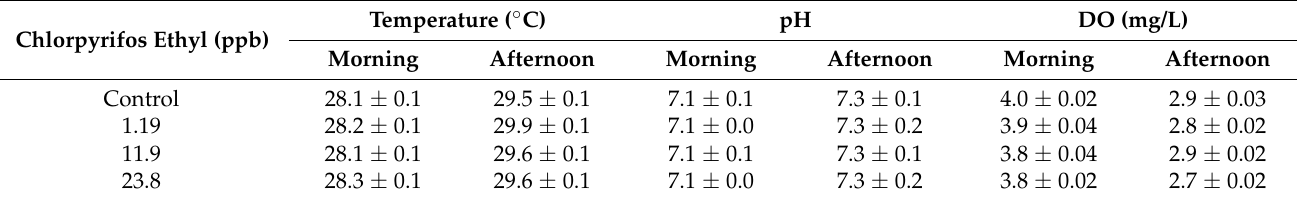
Table 2. Temperature, pH and DO of water in sub-acute experimental